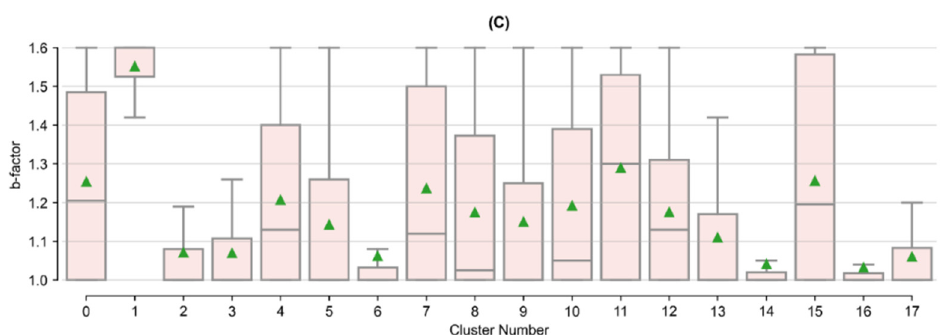
Figure 8. Box-and-whisker plots of Arps decline curve attributes calculated for wells within each cluster; including ( A ) initial oil production, ( B ) initial decline, and ( C ) b-factor. Boxes extends from the 25th to 75th quantile values of the data. A line occurs at the median (50th quantile). Green triangles occur at the mean value. Whiskers extend to the minimum and maximum values of the data absent outliers.